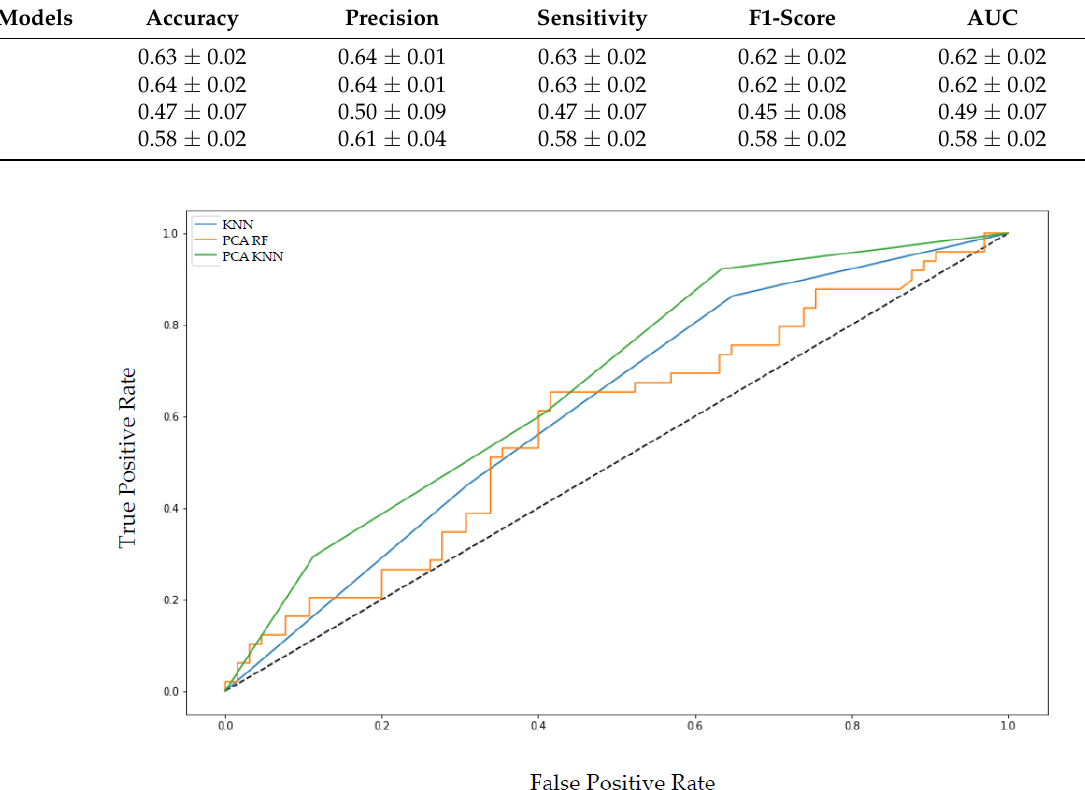
Table 2. The outcome of the radiomics-based machine learning models.